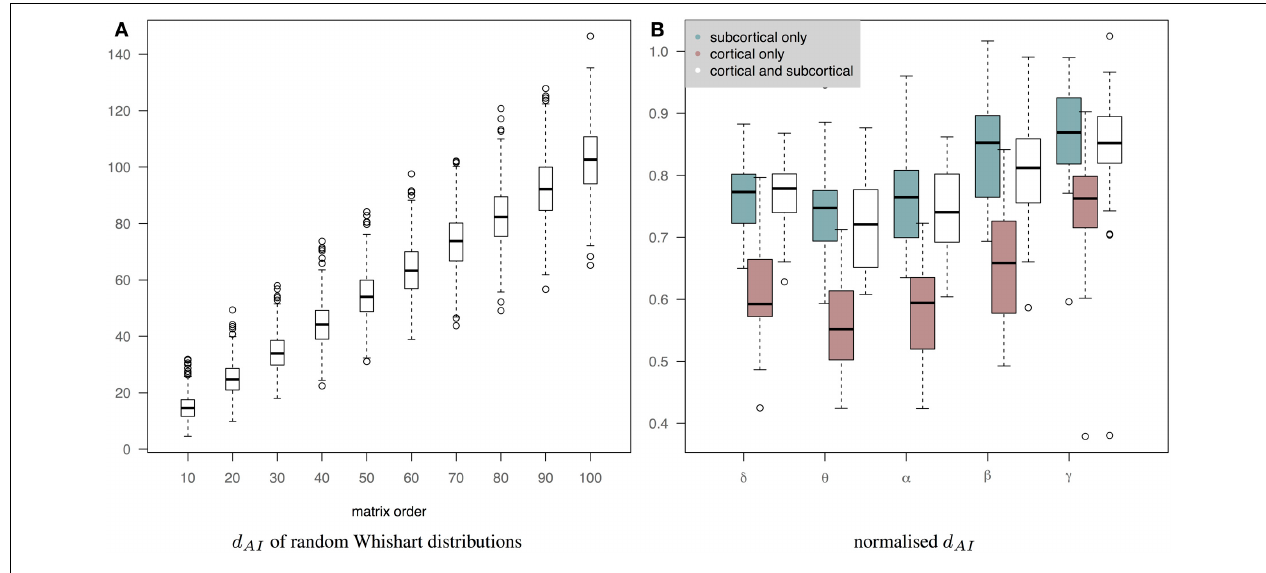
FIGURE 7 | (A) It shows how the d AI metric scales with the number of regions represented in the precision matrices. 1000 pairs of precision matrices were drawn from random Whishart distributions from matrix order of 10–100. Subsequently, the distance between the pair of matrices was estimated based on the d AI metric. (B) It shows the normalized distance